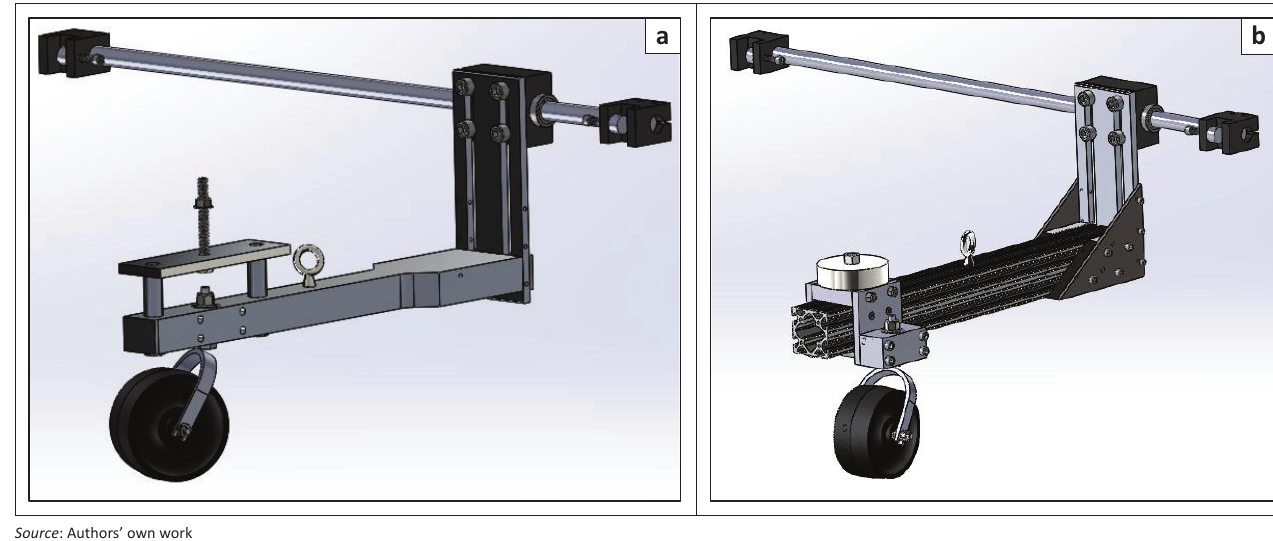
FIGURE 11: Initial design (left) and revised design (right).